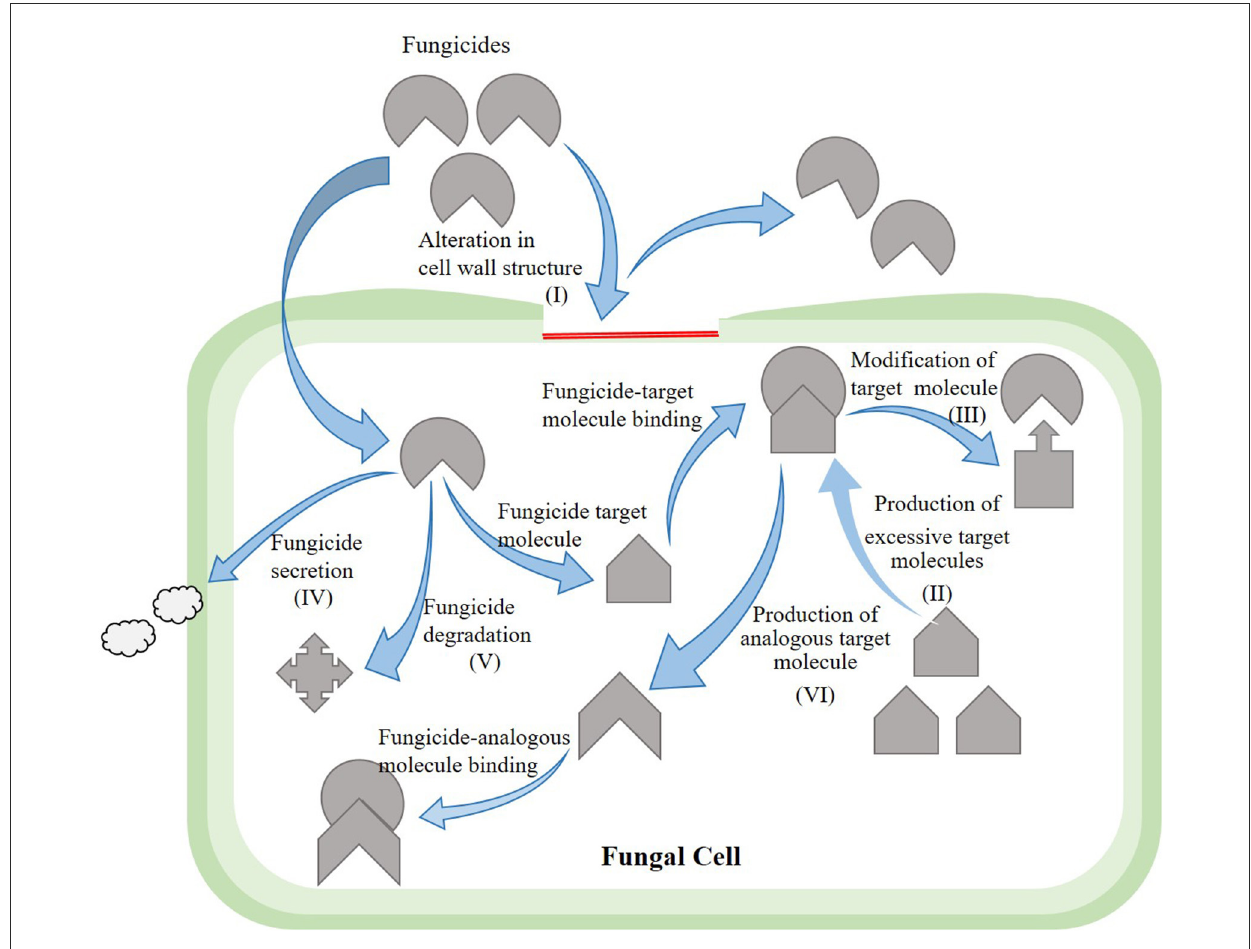
FIGURE6 Mechanism of resistance development in fungi against fungicides.